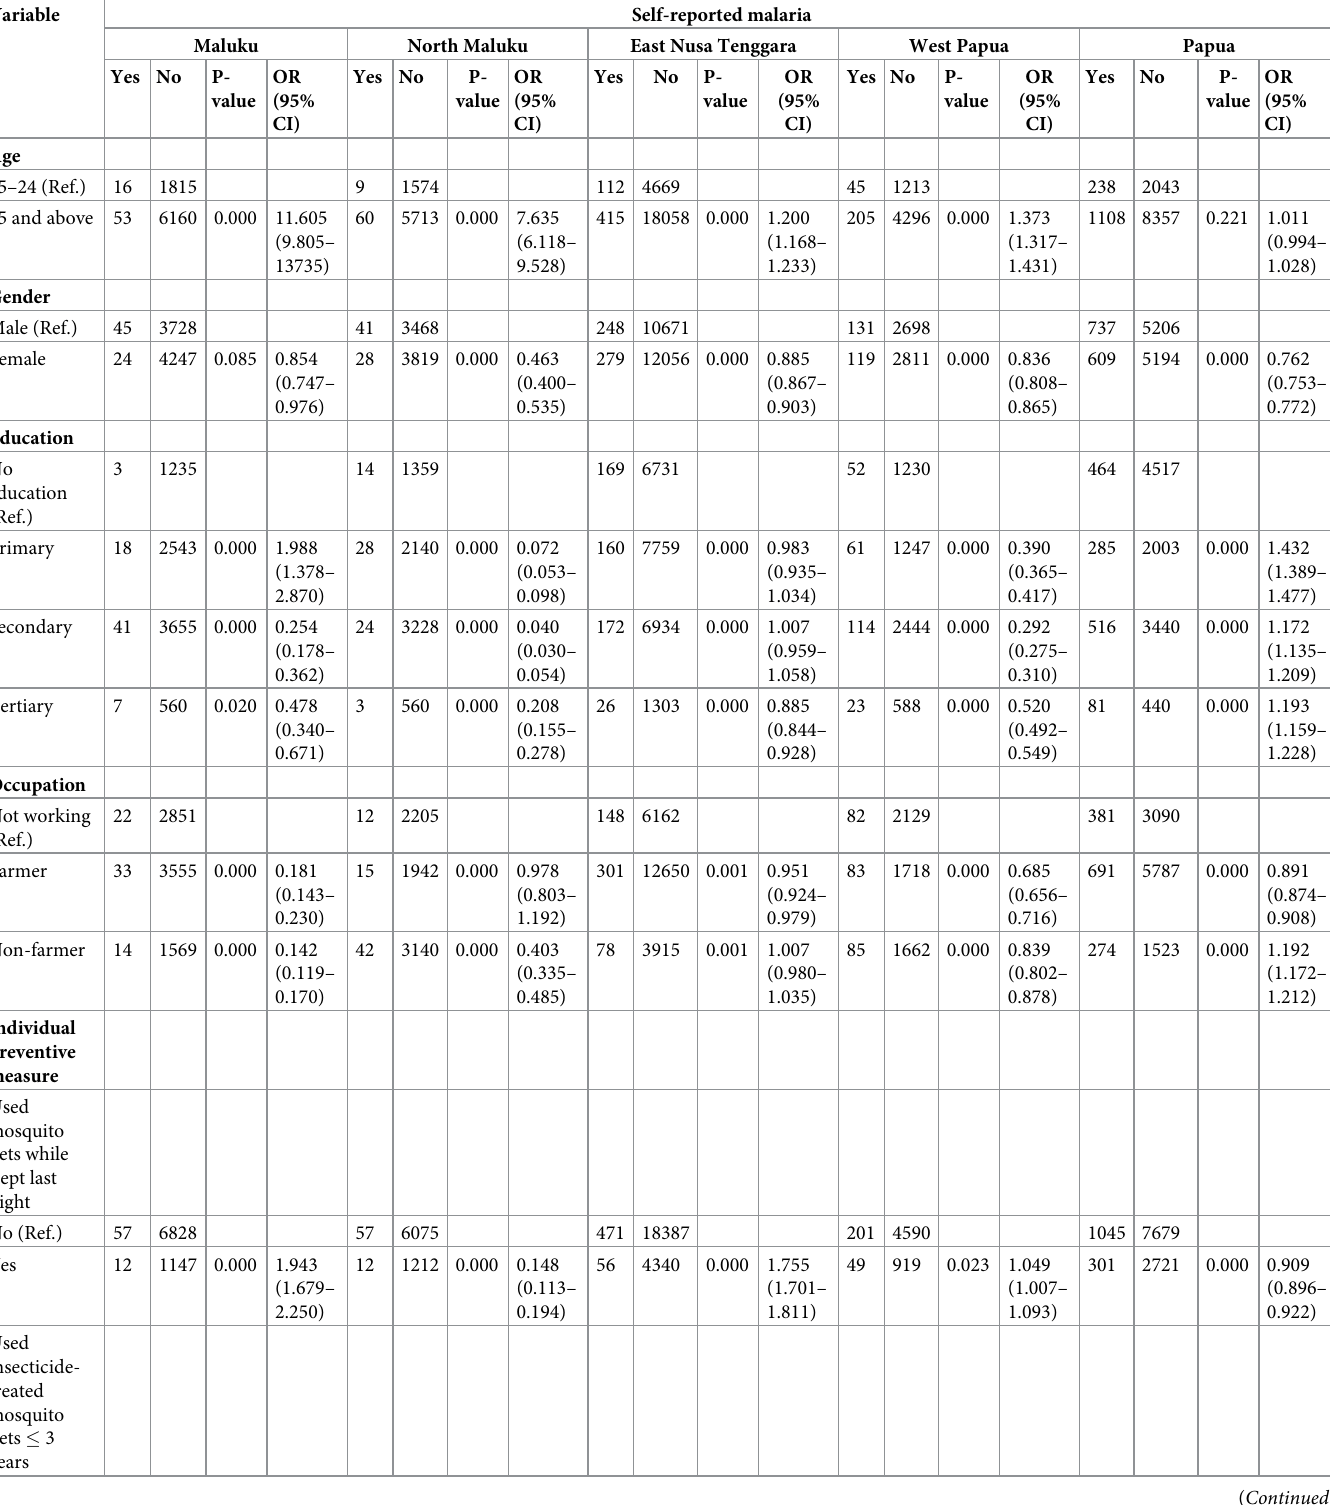
Table 2. Bivariate analysis of individual and household-level preventive practices and self-reported malaria among adults living in rural areas in five selected prov- inces in Indonesia.